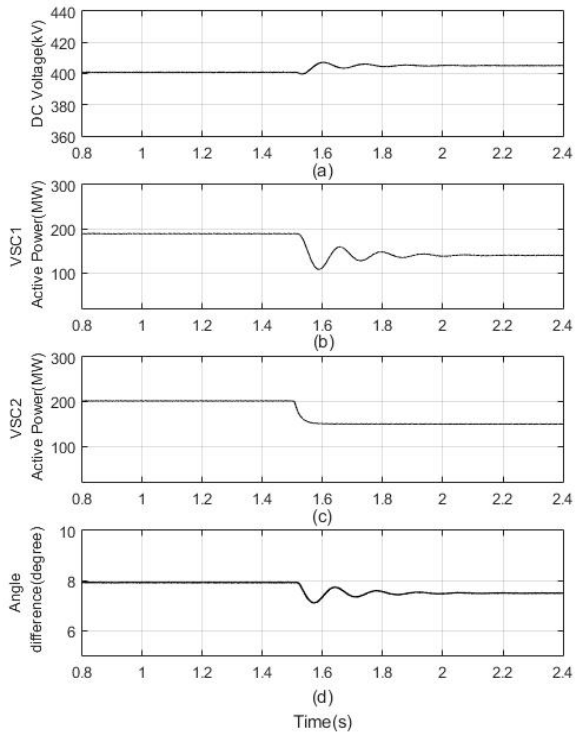
Figure 10. ATEC strategy for − δ ◦ scenario ( a ) DC voltage, ( b ) VSC 1 active power, ( c ) VSC 2 active power, and ( d ) angle difference.